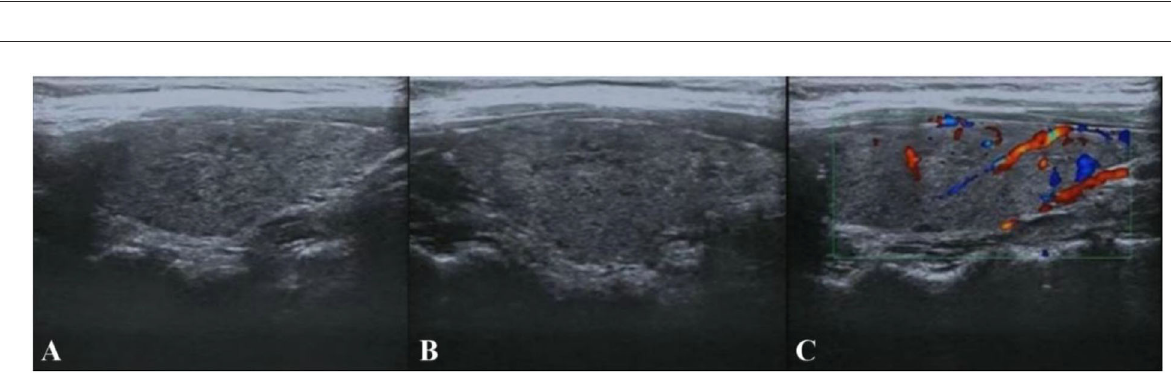
FIGURE2 Thyroid color ultrasound. (A,B) The size and morphology of the left and right lobes of the thyroid gland were normal, the thickness of the isthmus was normal, the border was clear, the envelope was intact, the internal echogenicity was diffuse rough and heterogeneous, lamellar hypoechogenicity was seen. (C) No abnormal flow signals were